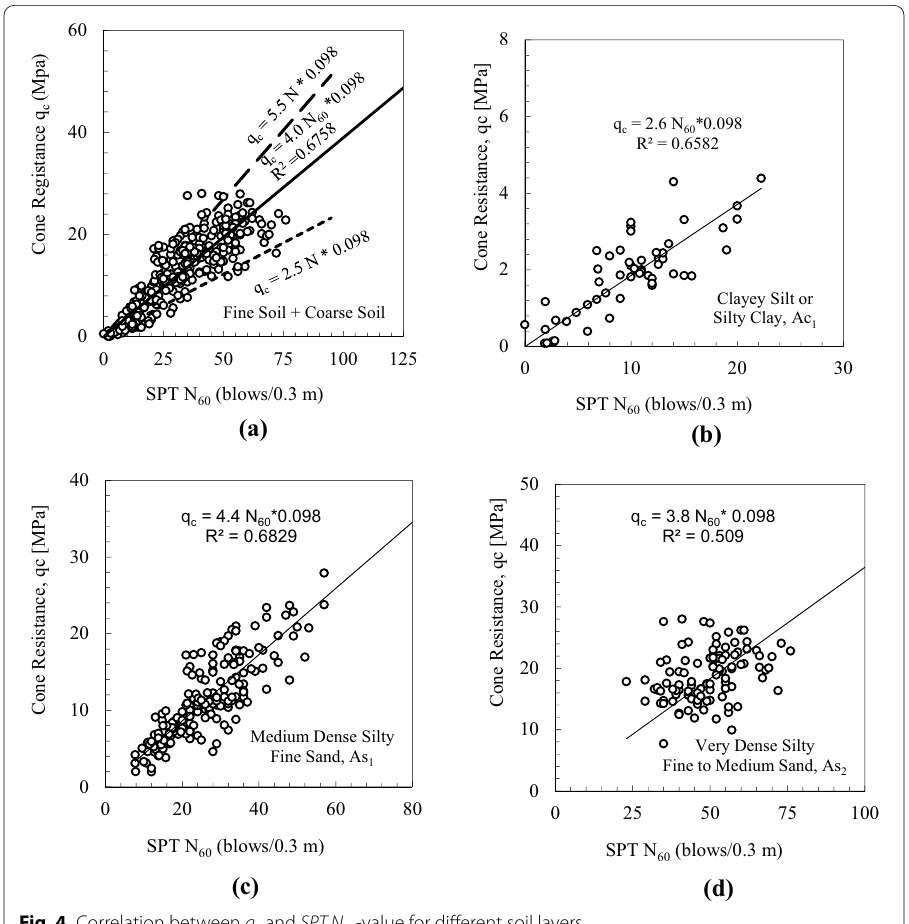
Fig. 4 Correlation between q c and SPT N 60 -value for different soil